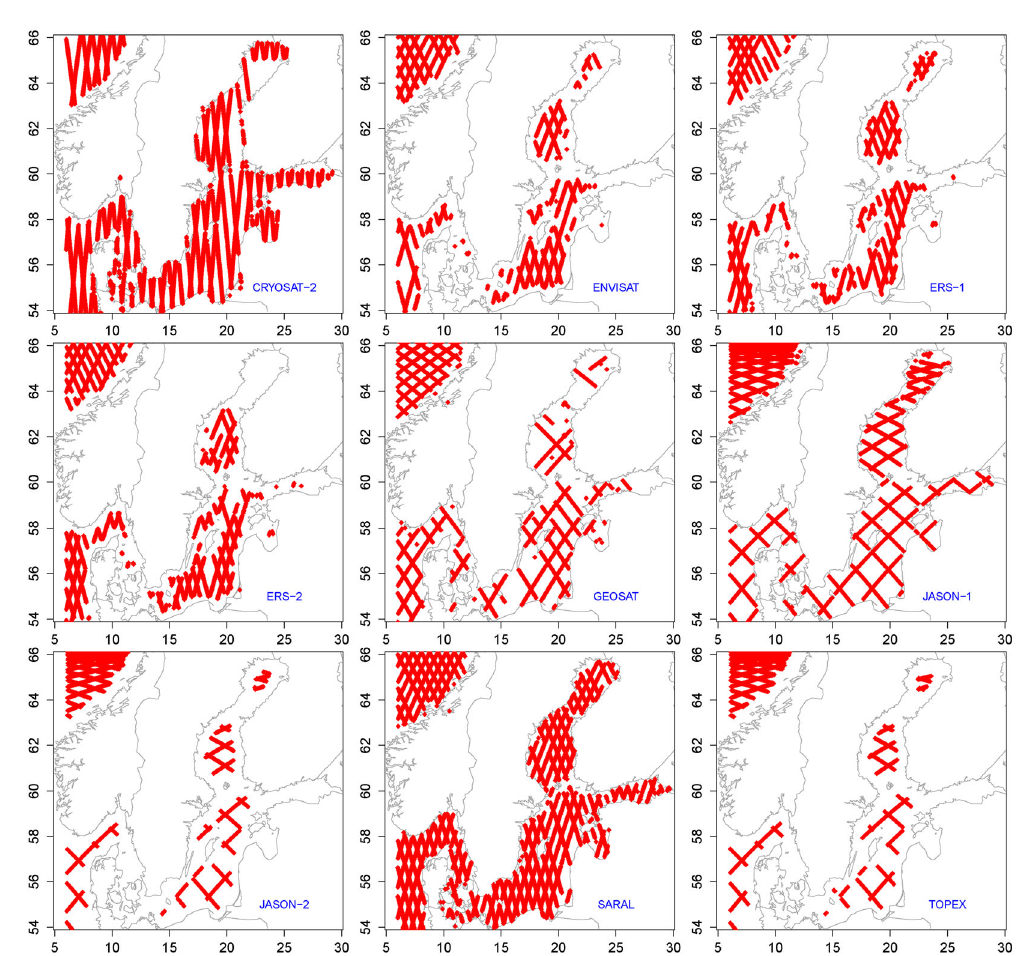
Fig. 1. Altimeter tracks during one month over the Baltic Sea. Latitude is shown at the y -axis and longitude at the x -axis.